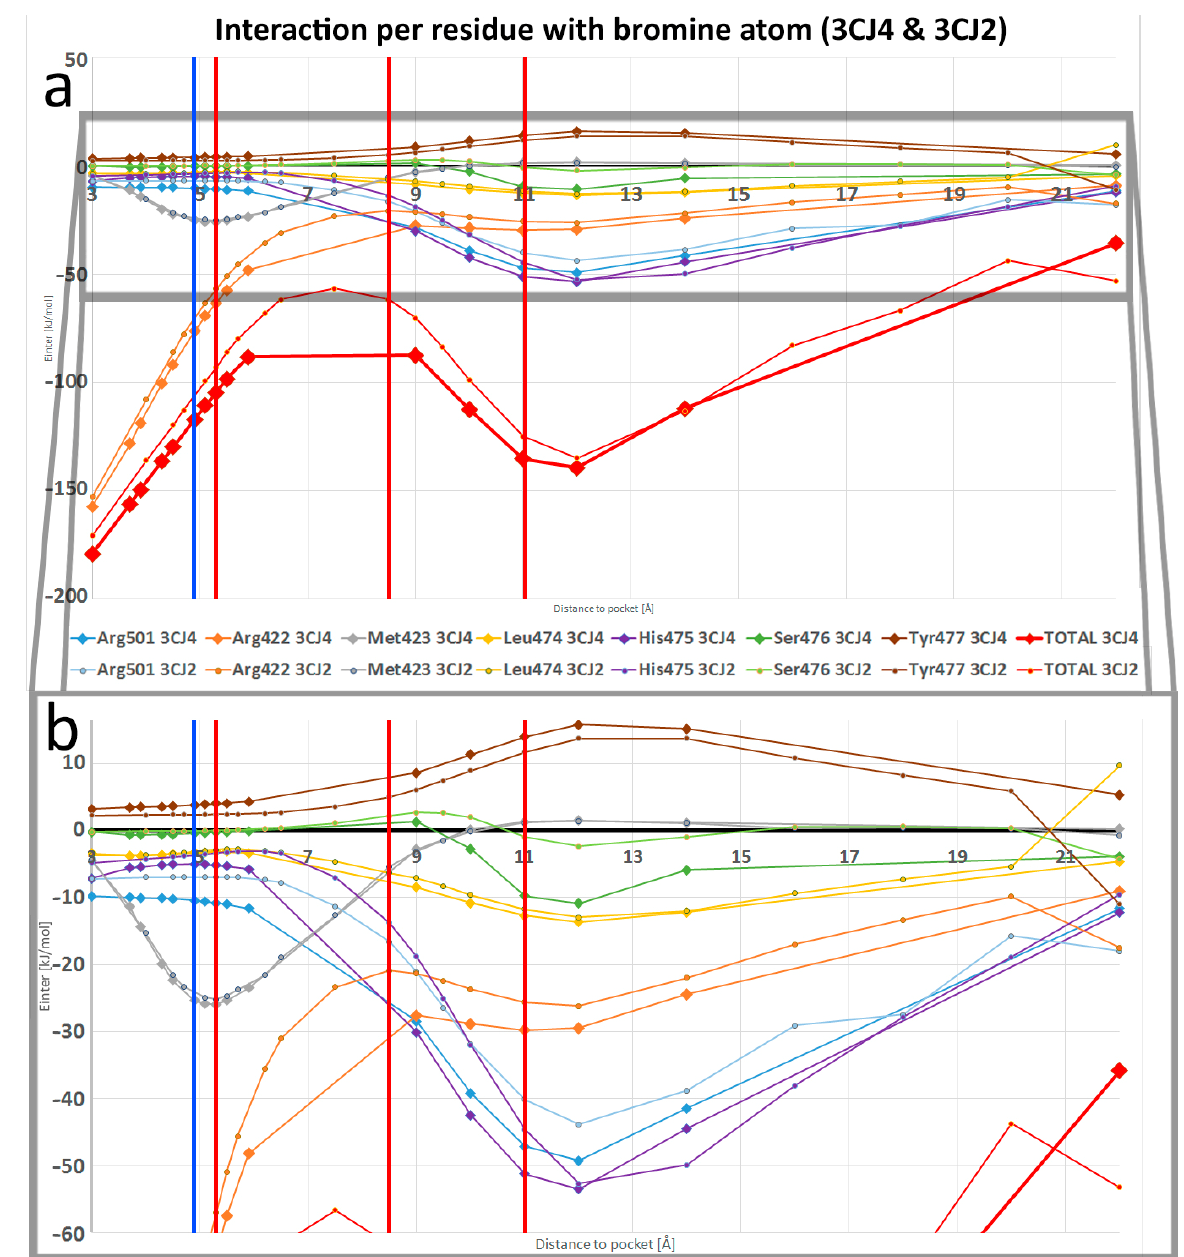
Figure 10. Contributions of each residue in 3CJ4 and 3CJ2 to the pocket–bromine interaction. Each contribution to the interaction is shown next to another interaction of the same colour, that is, the same equivalent interaction in the other system. All curves retain their shape regardless of the system. The separation between segments of the system’s PES is shown as vertical lines in blue (3CJ4) and in red (3CJ2). Panel ( a ) shows that even the total pocket–bromine interaction energy profiles are similar in both magnitude and shape. Panel ( b ) is an enlarged version of panel ( a ), which focuses more on the contributions per residue and confirms that the interactions of bromine in segment 3 of 3CJ2 are largely caused by His475, Arg501, and to a smaller degree by Ser476. This insight had also been obtained with the REG method (Table 8). These interactions in 3CJ2 are the same as well for bromine in 3CJ4, but, as shown in the PES of Figure 4a, in 3CJ4 there is no local maximum and minimum caused by the bromine interactions; its effect is masked in the 3CJ4 PES by all the extra hydrogen